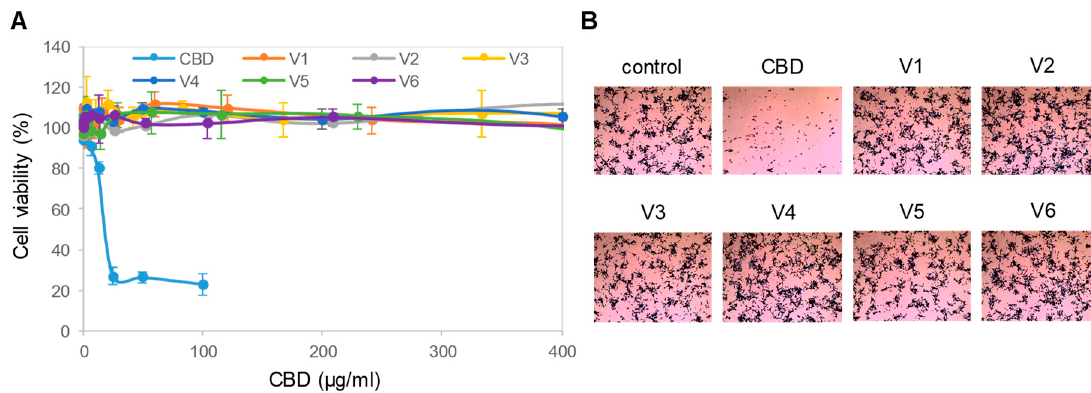
Figure 2. Toxicity of isolated CBD on neuronal cells. ( A ) Viability of SH-SY5Y cells as a function of treatment with isolated CBD and CBD oils. Error bars were standard deviations across 6 repeated measurements per experimental condition. Cell viability was measured with MTS assays; ( B ) density of SH-SY5Y cells as a function of treatment with a CBD isolate and CBD oils. SH-SY5Y cells were stained with crystal violet dye and examined with a standard brightfield cell culture microscope. The image field of view has a xy dimension of 1500 µm x 1125 µm.